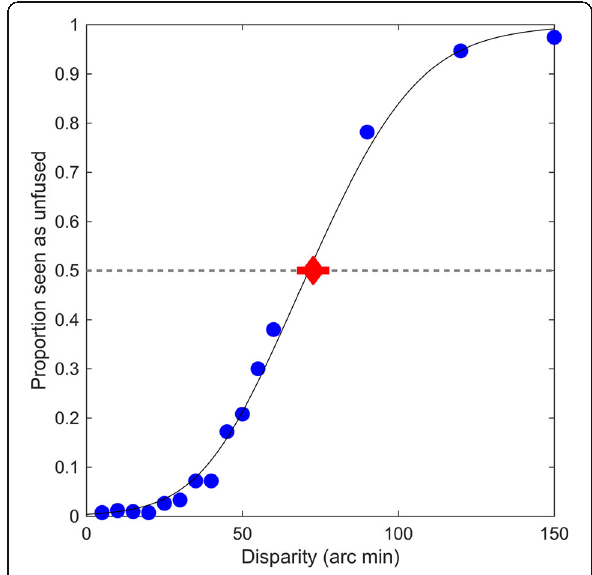
Fig. 5 Proportion of stimuli seen as unfused, as a function of the disparity separation between the two planes. The blue dots show the mean proportion of unfused responses across participants, the black curve the average of the individual psychometric curve fits. The red diamond shows the mean 50% points, across participants; the horizontal error bar indicates ±1 standard